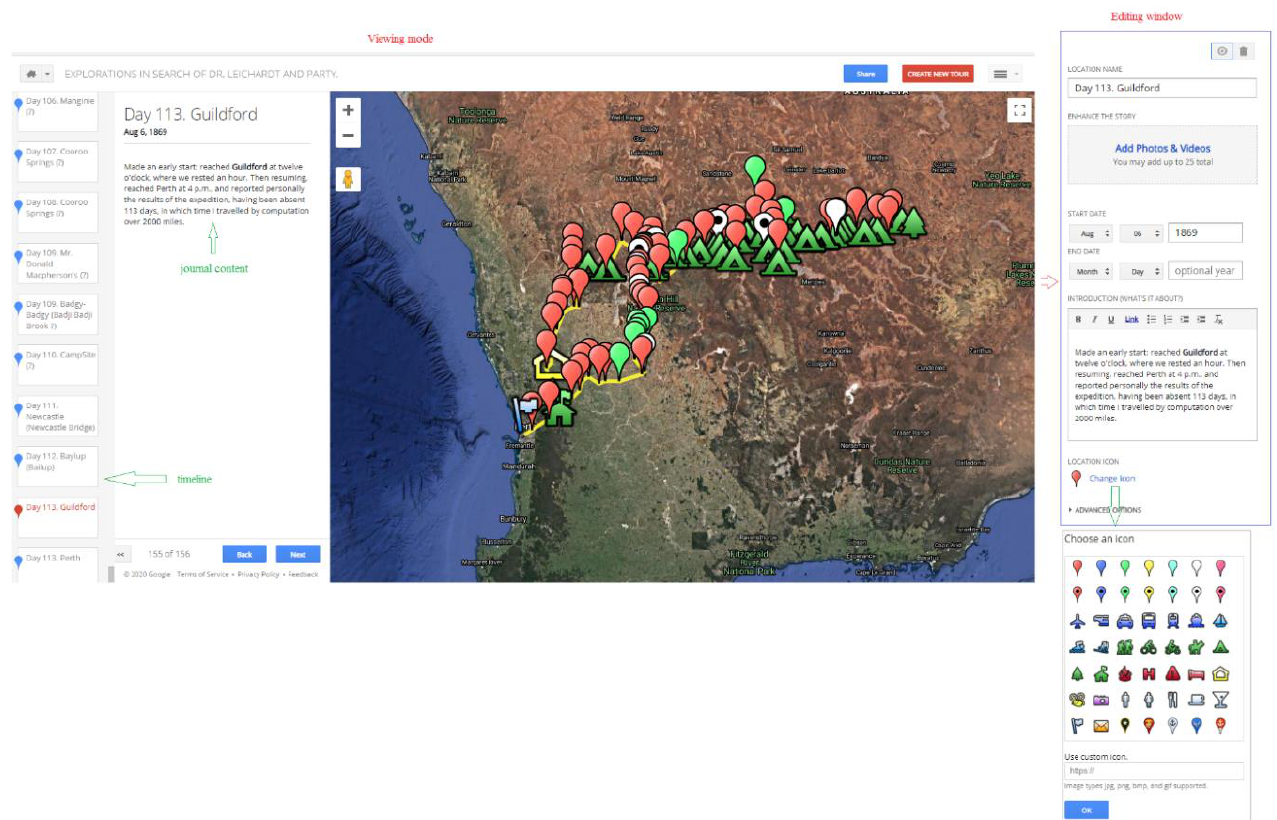
Figure 5. Interactive time map built with Tour Builder.